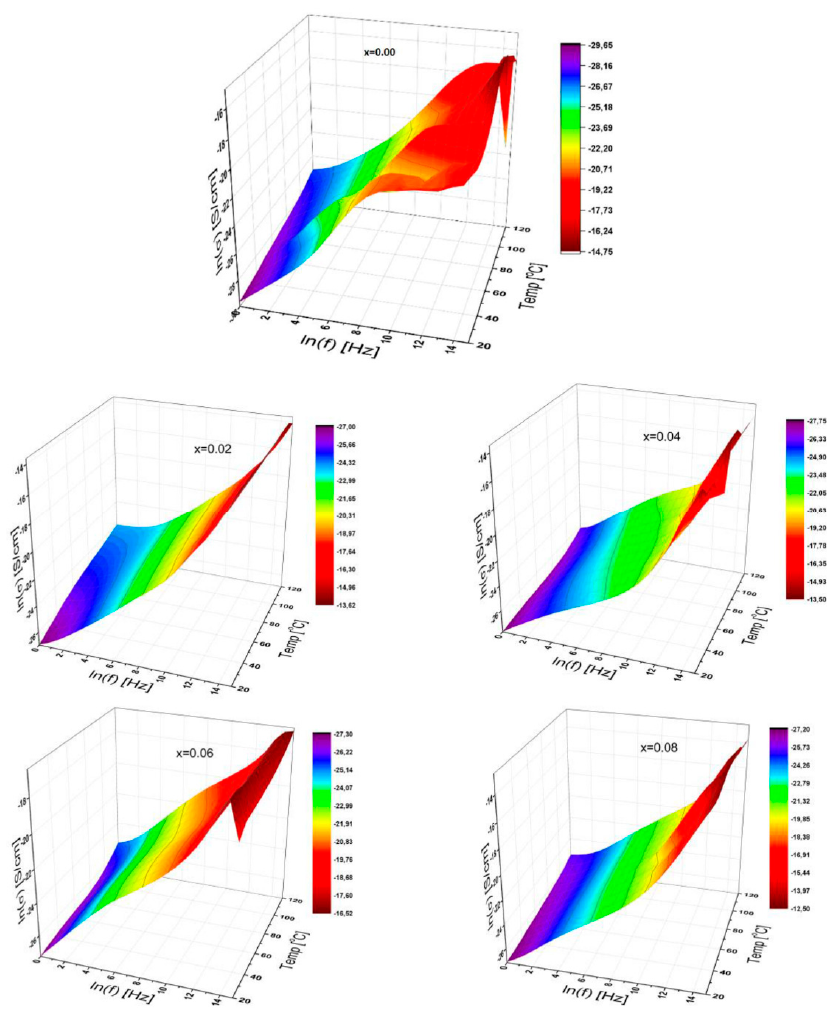
Figure 4. 3D characteristic plots of AC conductivity of SrNb x Fe 12 − x O 19 (0.00 ≤ x ≤ 0.08) HFs for various Nb doping ratios as a function of frequency up to 3 MHz, and for temperatures up to 120 °C.